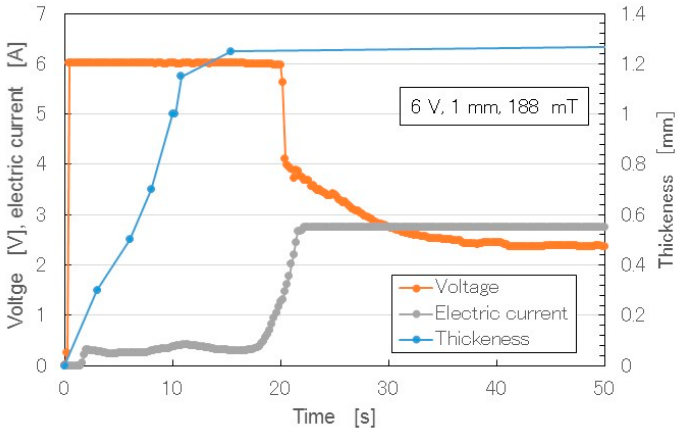
Figure 12. Changes in voltage, electric current, and thickness of MCF rubber over time during the period of vulcanization with the new method.